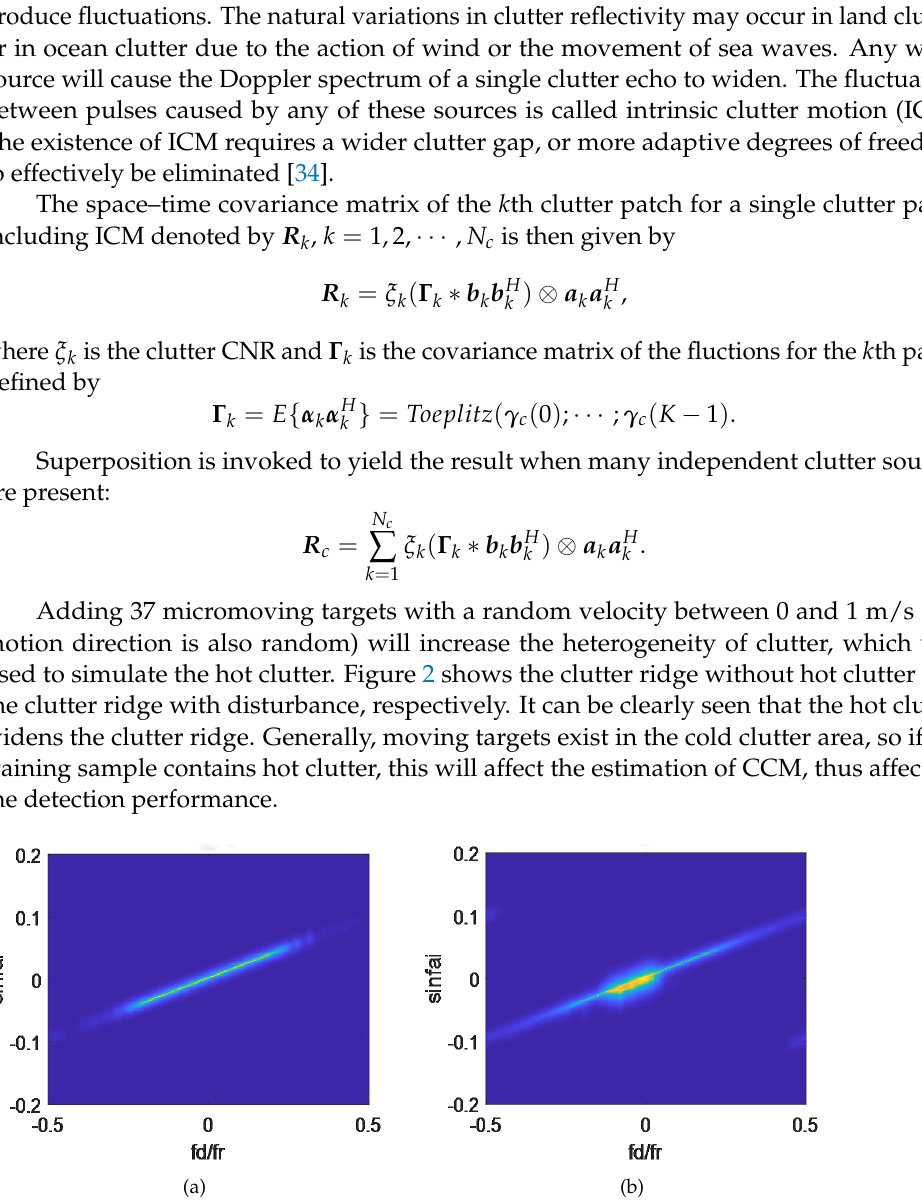
Figure 2. Clutter ridge ( a ) the clutter ridge without hot clutter ( b ) the clutter ridge with hot